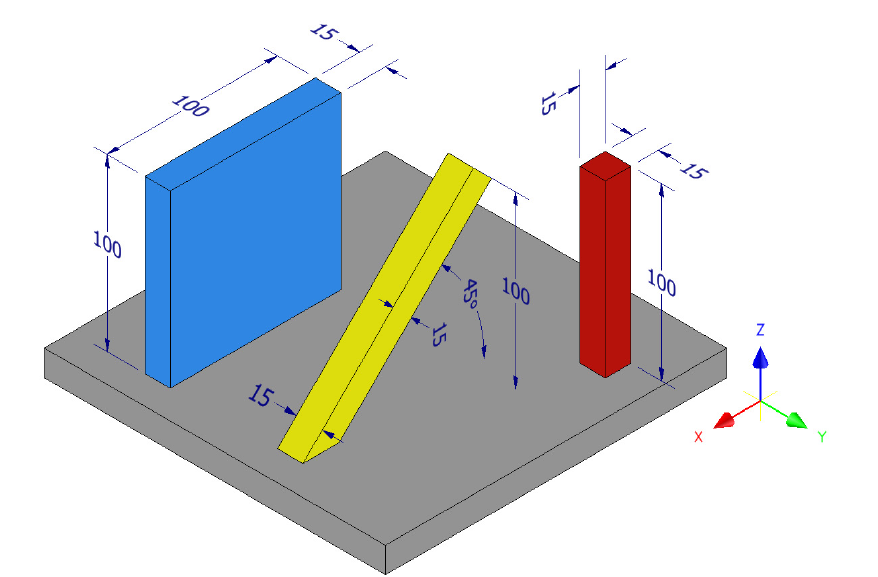
Figure 2. Geometry (in mm) and orientation of the specimens. Note: Z is the build